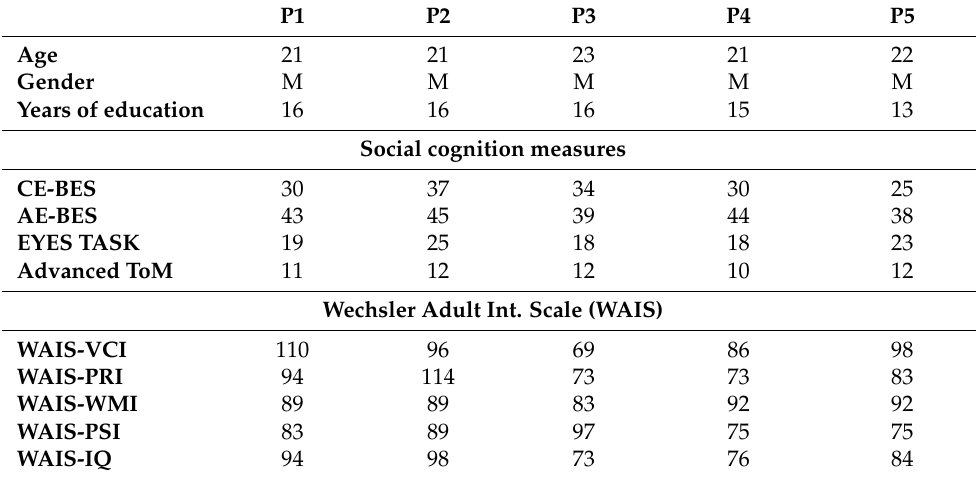
Table 1. Characterization and IQ of study